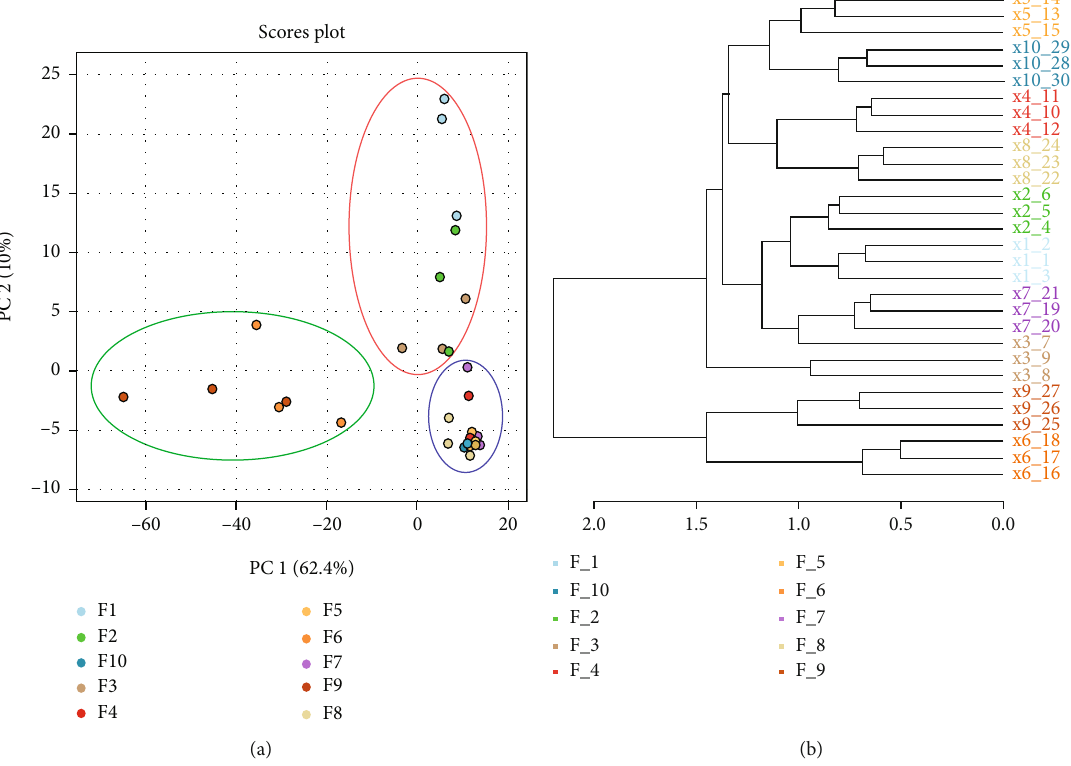
Figure 1: (a) Principal component analysis (PCA) of herbal infusions prepared with cocoa bean shell, I. guayusa and V. patens from the GC- MS data. (b) Dendrogram resulting from a hierarchal cluster analysis based on the distribution of all detected